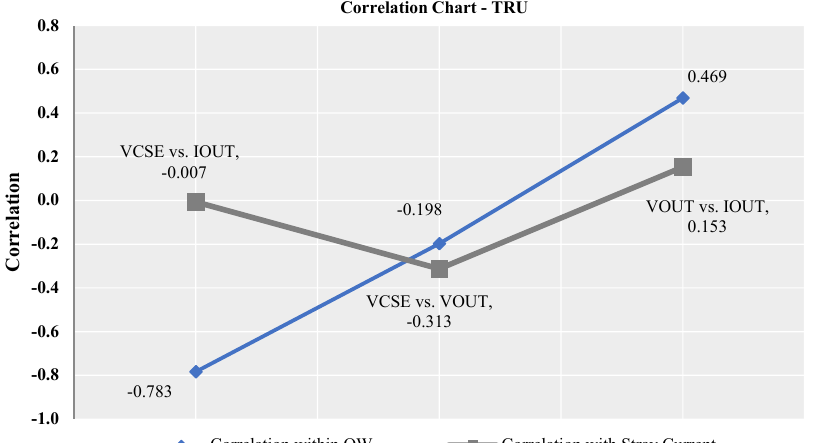
Figure 10. TRU correlation result comparison.